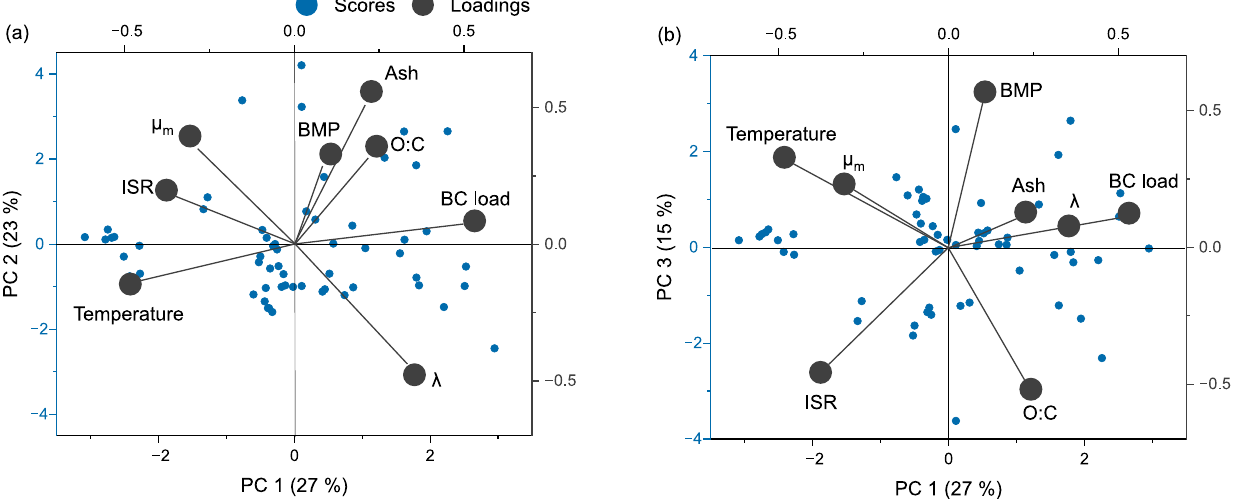
Figure 2. Principal component analysis biplot for the parameters influencing biochar augmentation in anaerobic digestion: ( a ) PC1 vs. PC2; ( b ) PC1 vs. PC3. Pyrolysis temperature (PT); methane yield (BMP); µ m methane production rate; λ lag phase; ISR inoculum-to-substrate ratio; biochar ash content; biochar O:C ratio dry ash-free basis; biochar load. The dataset is listed in Supplementary